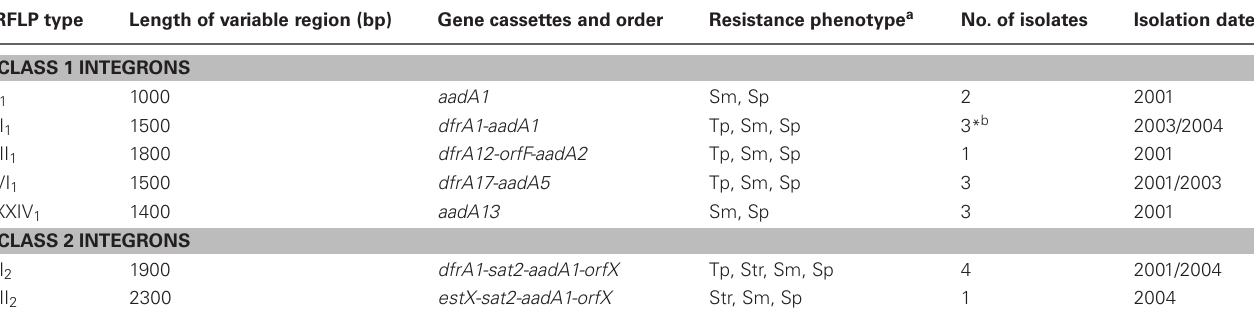
Table 2 | Class 1 and class 2 integron types found among Enterobacteriaceae recovered from faecal samples of Portuguese healthy